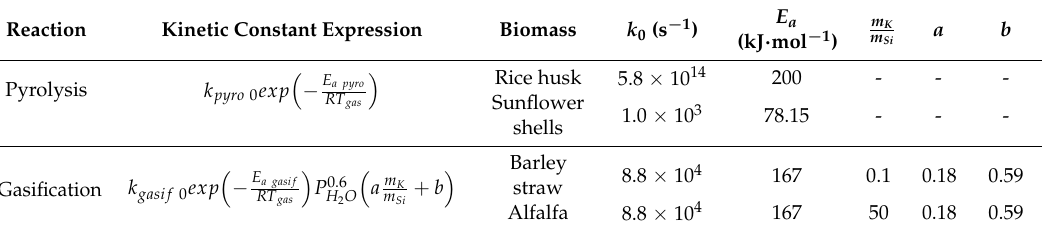
Table 5. Kinetic constants for pyrolysis and gasification reactions.